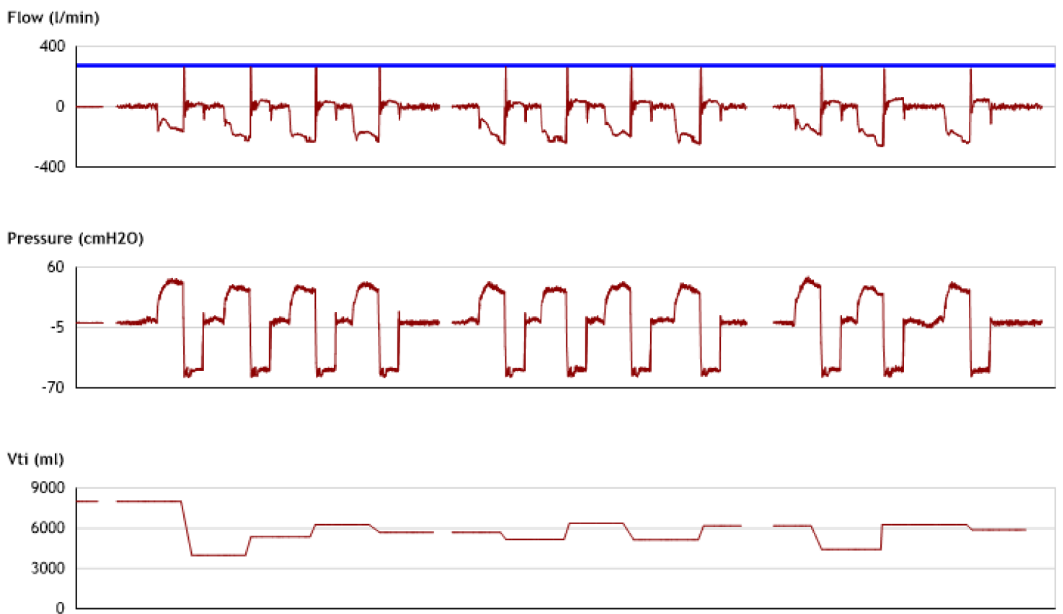
Figure 6. Shows the flow, pressure, and inspiratory tidal volumes (Vti) download for a patient using an E70 (Philips Respironics, Murrysville, PA, USA). The blue line shows the device assisted cough peak flow (CPF) of around 350 L/min. Clinicians would normally be very pleased with this reading as it is at a level that would indicate an effective assisted CPF. However, after the initial CPF, there is flattening of the exsufflation curve, indicating an obstructed airway. With thanks to Tiago Pinto.